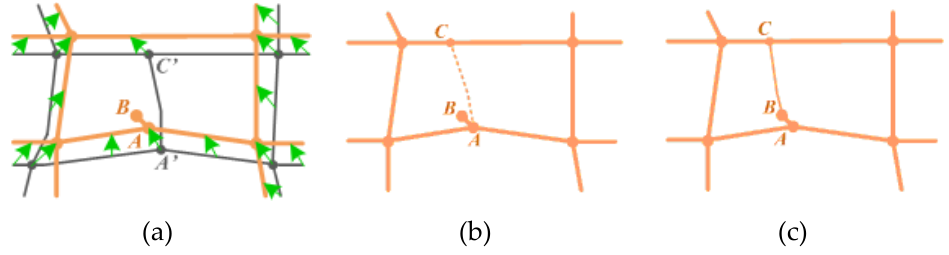
Figure 7. The process to solve the problems of partial duplications: ( a ) data matching; ( b ) data conflation; ( c ) error correction. Orange lines: NAVTEQ; grey lines: ATKIS; dashed lines: conflated pedestrian ways; dashed lines: conflated pedestrian ways; green arrows: linkages.